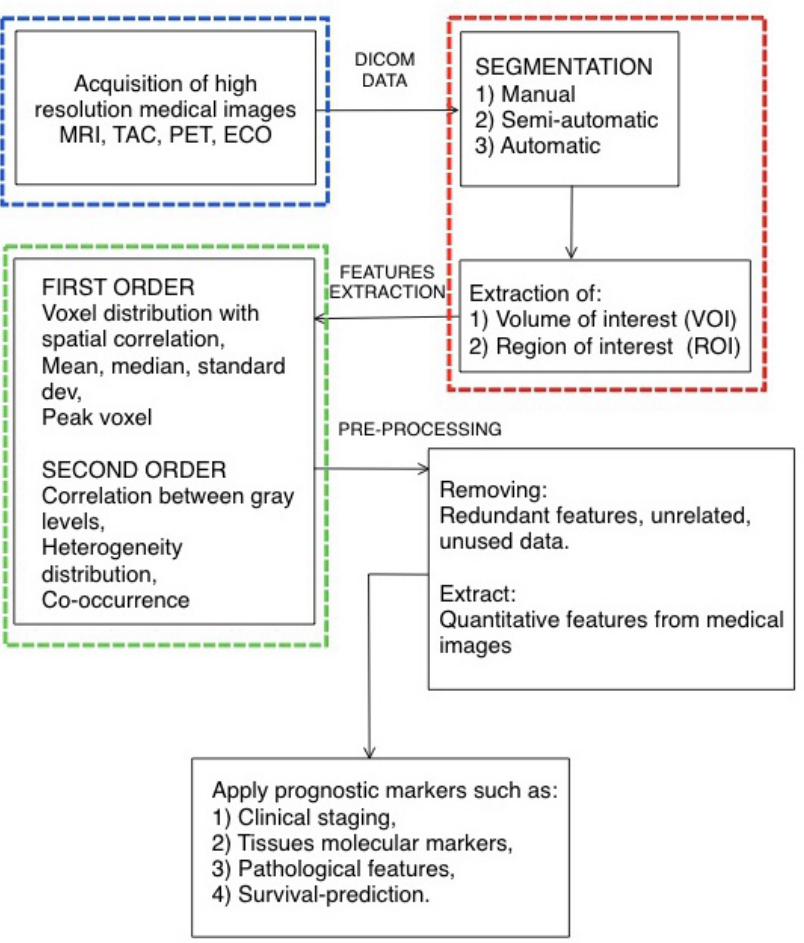
Figure 1. Workflow schema of a typical radiomic